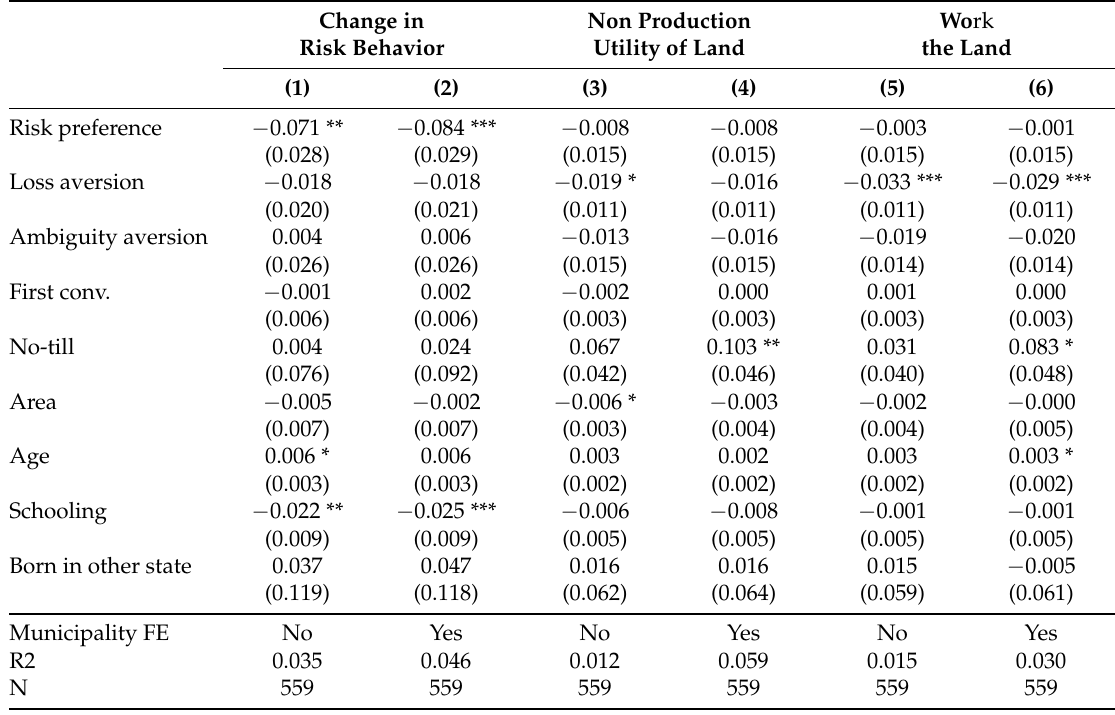
Table 7. Associations between switching behavior and subject